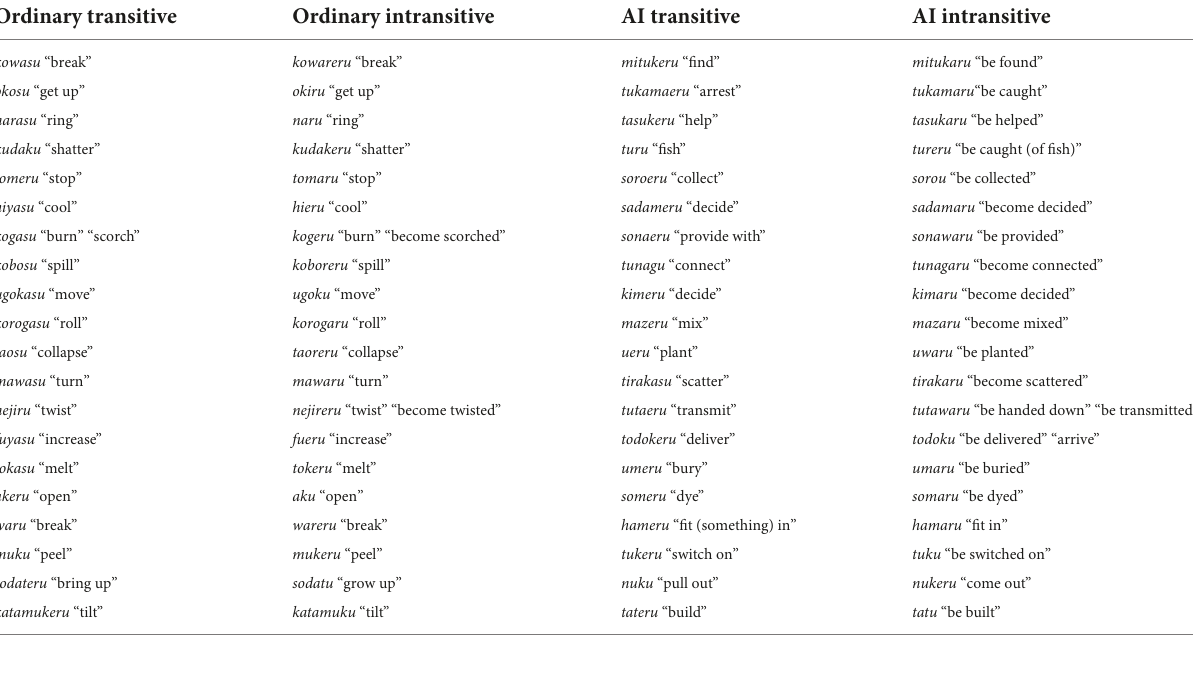
TABLE 1 Japanese verbs used in the norming task and the priming experiment. Ordinary transitive